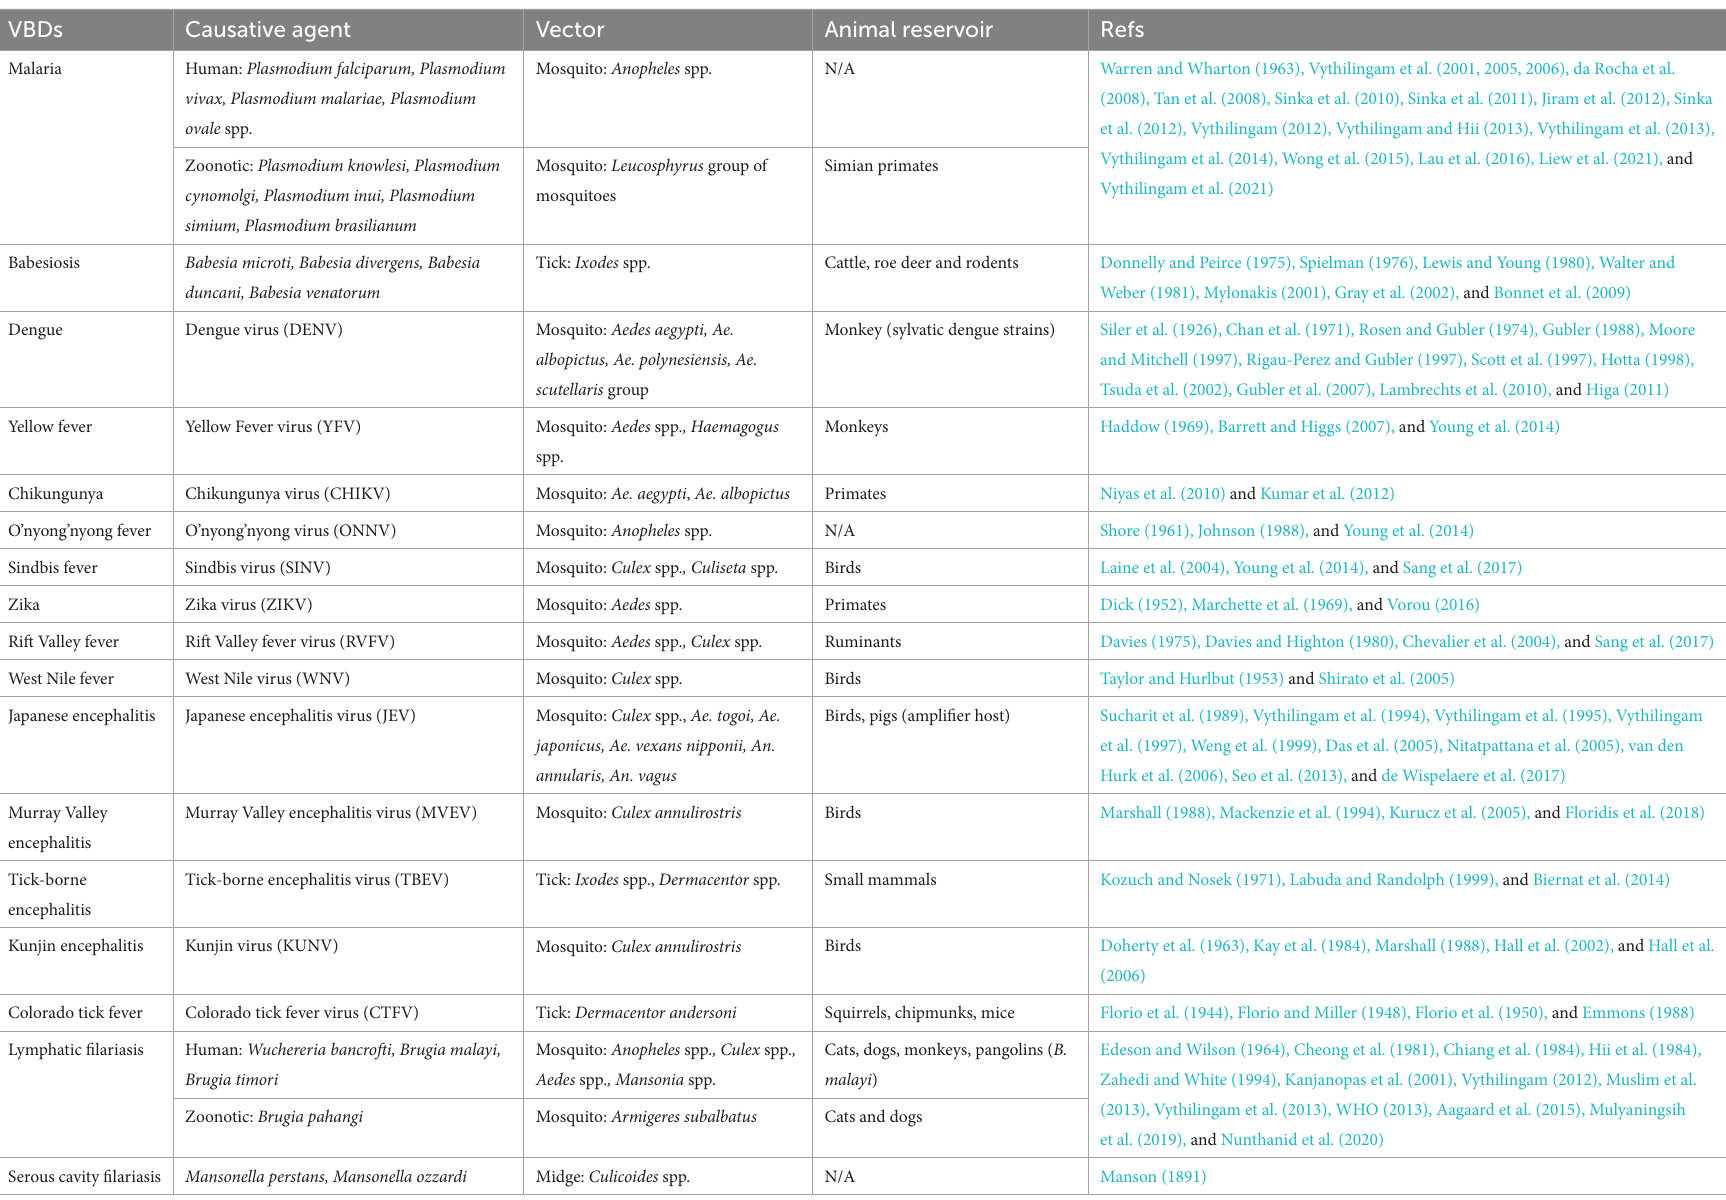
TABLE 1 Vector-borne diseases (VBDs) and the respective vectors and animal